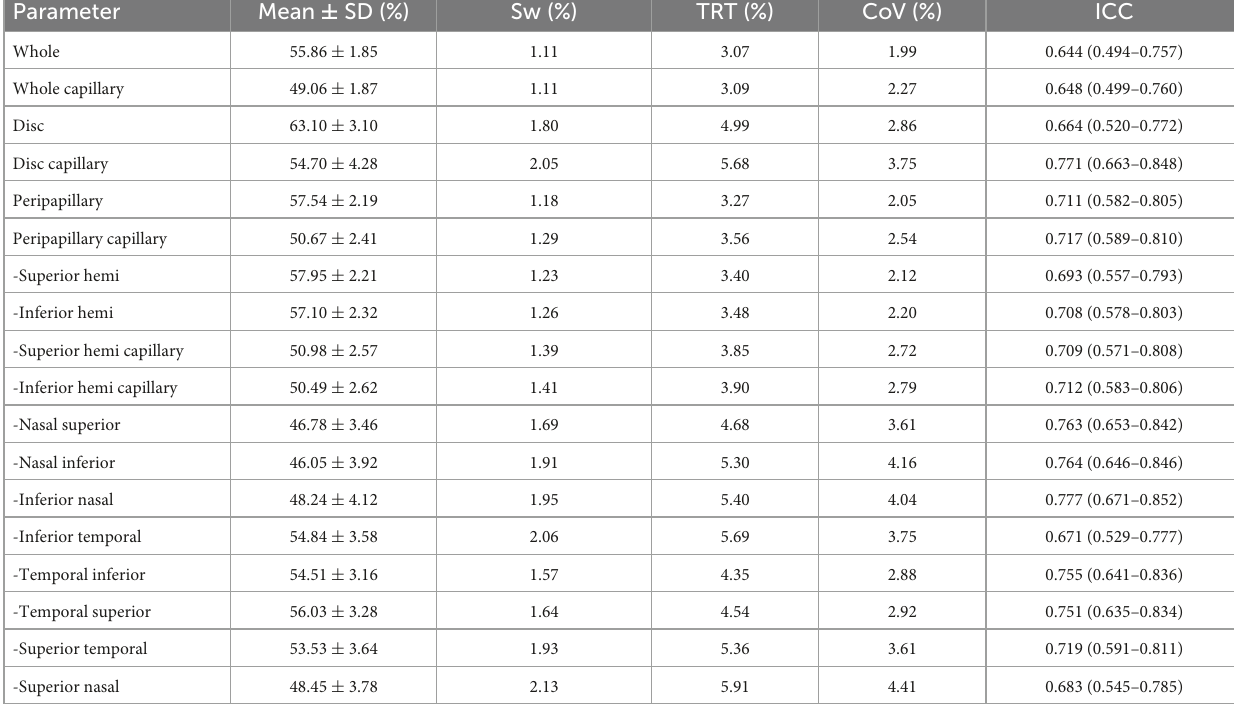
TABLE 2 Inter-examiner agreement of the OCTA in measuring the papillary and peripapillary vascular density. Parameter Mean ± SD (%) Sw (%) TRT (%) CoV (%)